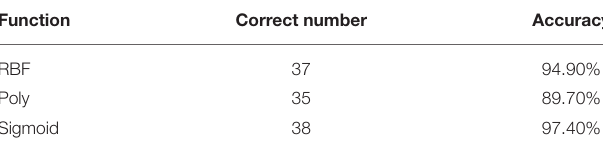
TABLE 3 | Test the model’s independent prediction ability by